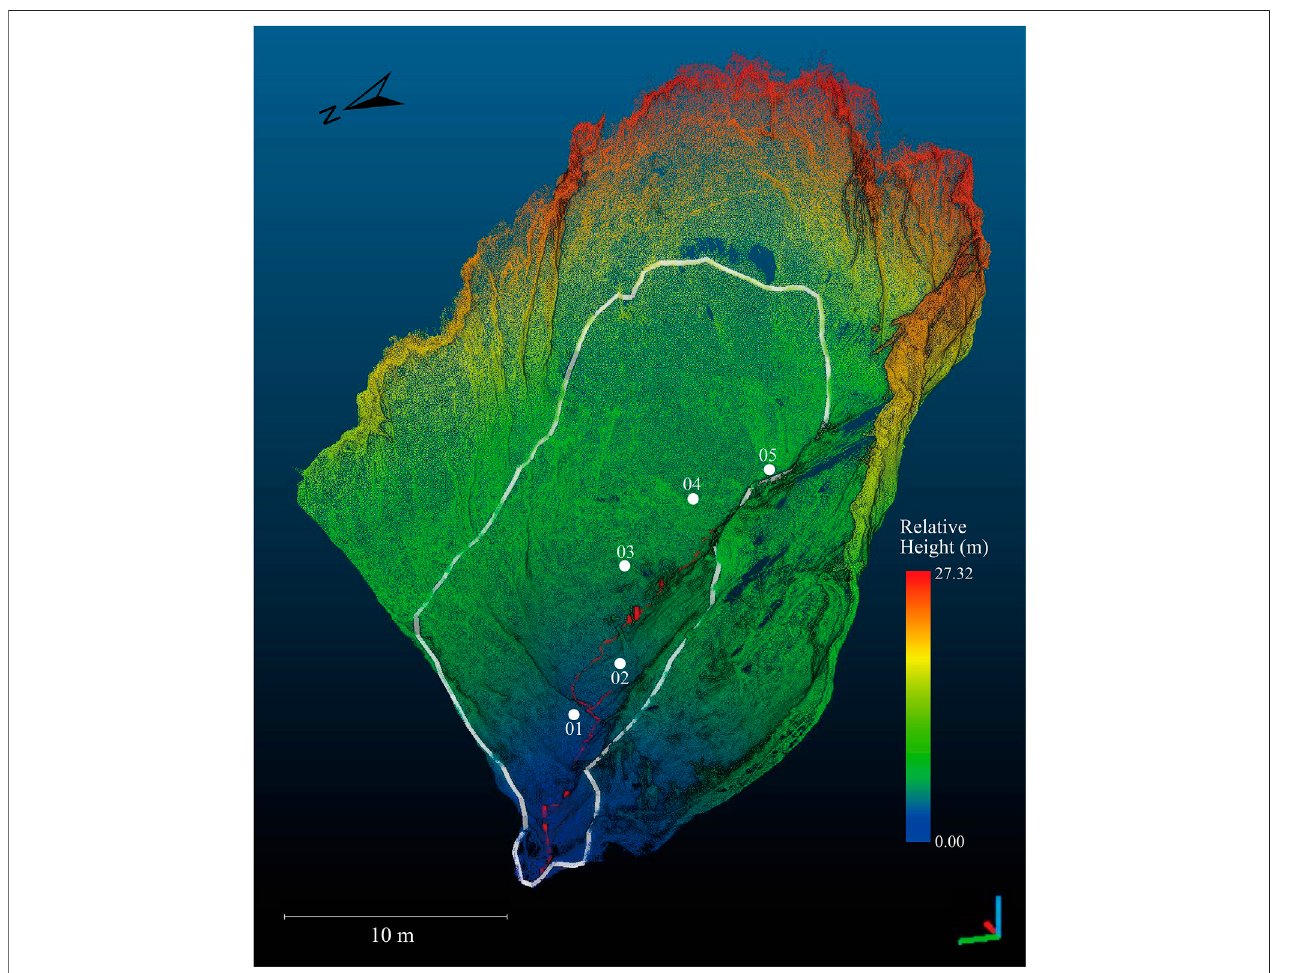
FIGURE 2| A three-dimensional perspective view ofthe gully point cloud on December 24, 2014, illustrating nearly verticalgully headwall and sidewalls. The white dots represent the scan locations and the dash red line represents the stream line of the gully bottom. The white polygon represents the boundary of the gully chancel, which is the focused area of the